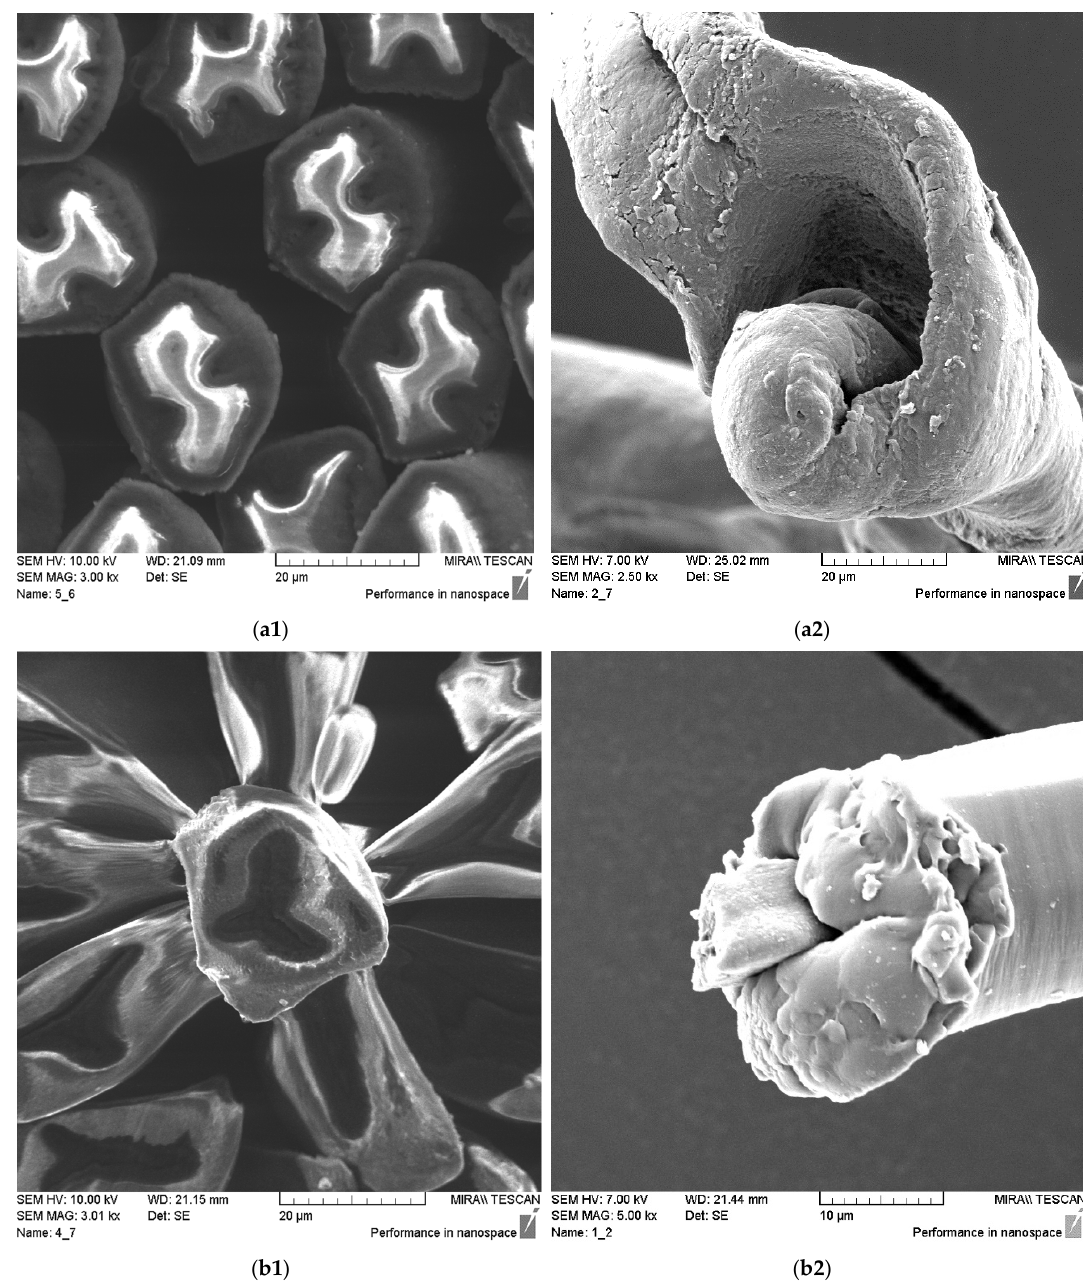
Figure 3. Bicomponent carbon fibre (CF) represented in: ( a ) samples 1–4 (magnification: ( a1 ) ×3000, ( a2 ) ×5000); ( b ) samples 5–6 (magnification: ( b1 ) ×3000, ( b2 ) ×5000).